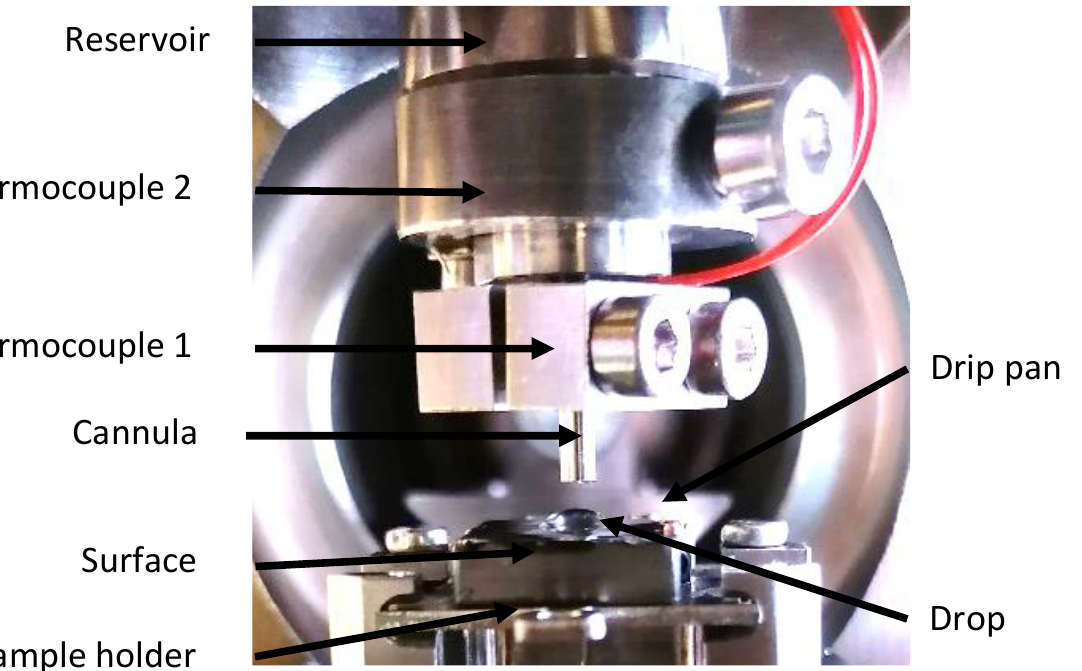
Figure 5. View into chamber for sessile drop measurements. A sample holder is positioned directly under the cannula to place a drop on a sample surface.